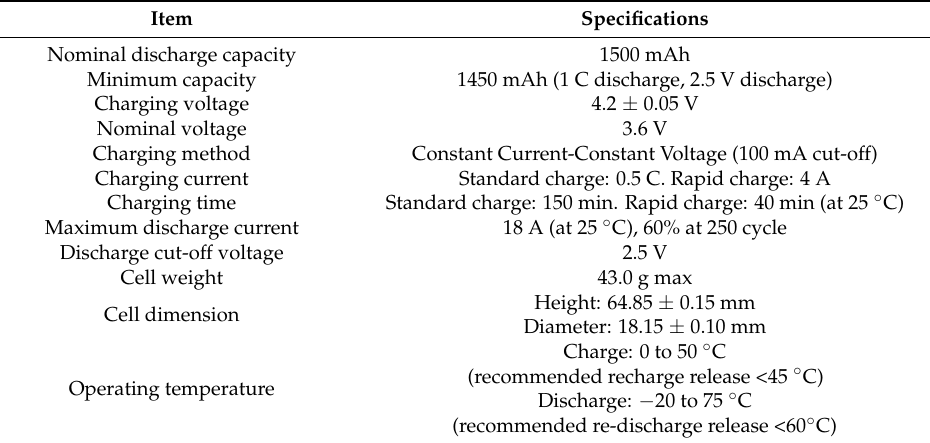
Table 1. Samsung INR18650-15L battery